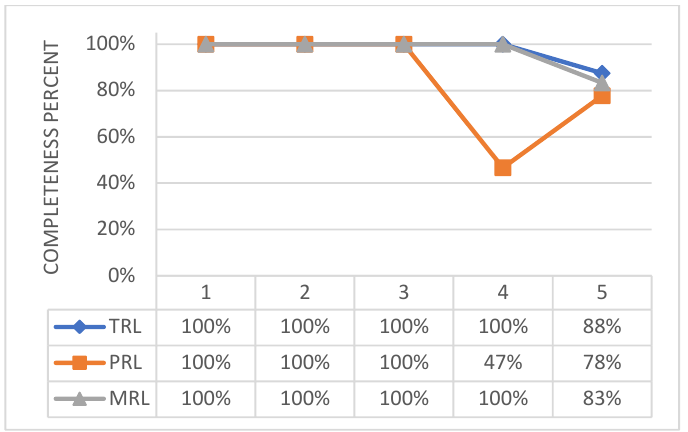
Figure 14. Technological, programmatic, and manufacturing level of maturity (b) of the adaptive flap actuation system.